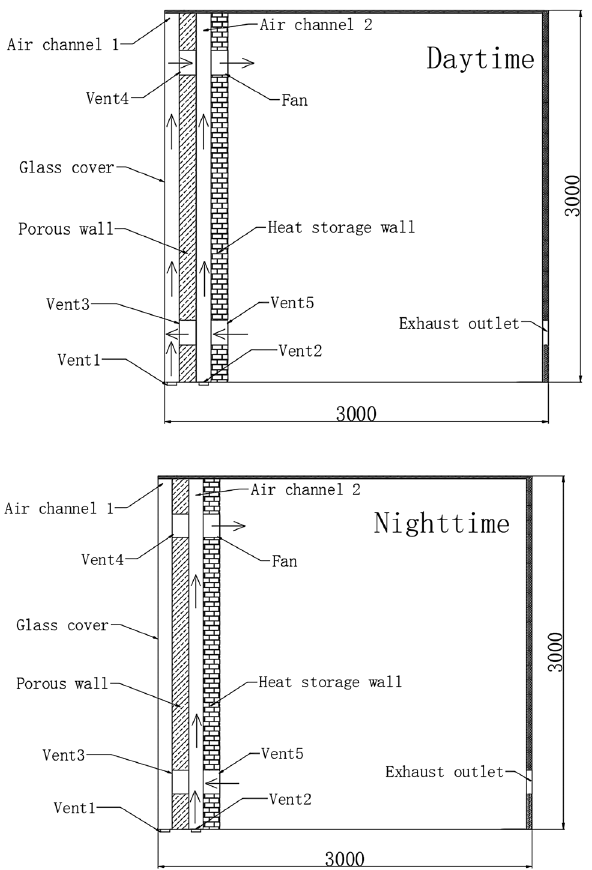
Figure 1. Schematic of double-channel porous solar